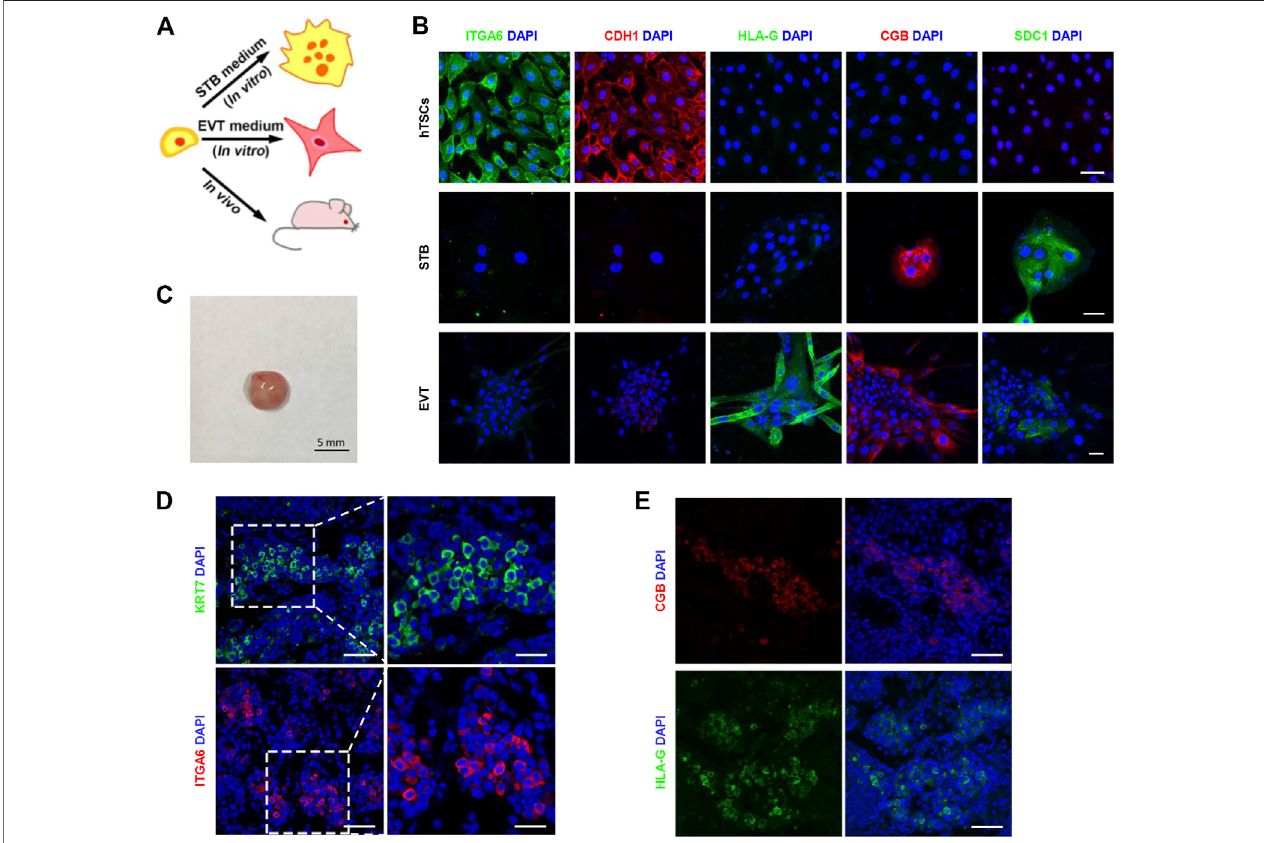
FIGURE 2 | The in vitro and in vivo differentiation potential of hTSCs. (A) Cartoon depicting the differentiation strategy of hTSCs in vitro and in vivo . STB, syncytiotrophoblast; EVT,extravilloustrophoblastcells. (B) DifferentiationofhTSCsintoSTBandEVT.ImmunostainingofITGA6 and CDH1(markers ofcytotrophoblast cells); SDC1 and CGB (markers of STB); HLA-G (a marker of EVT). DAPI, blue, DNA. Scale bars, 50 μ m. (C) Injection of hTSCs (1 × 10 7 ) into non-obese diabetic (NOD) severe combined immunode fi ciency (SCID) mice. A teratoma from the NOD-SCID mice by day 7. Scale bar, 5 mm. (D) Immunostaining of KRT7 (a marker of trophoblast cells) and ITGA6 in a hTSCs-derived lesion. DAPI, blue, DNA. Scale bars, 50 and 20 μ m (magni fi ed areas). (E) Immunostaining of CGB and HLA-G in a hTSCs-derived lesion. DAPI, blue, DNA. Scale bars, 20 μ m.